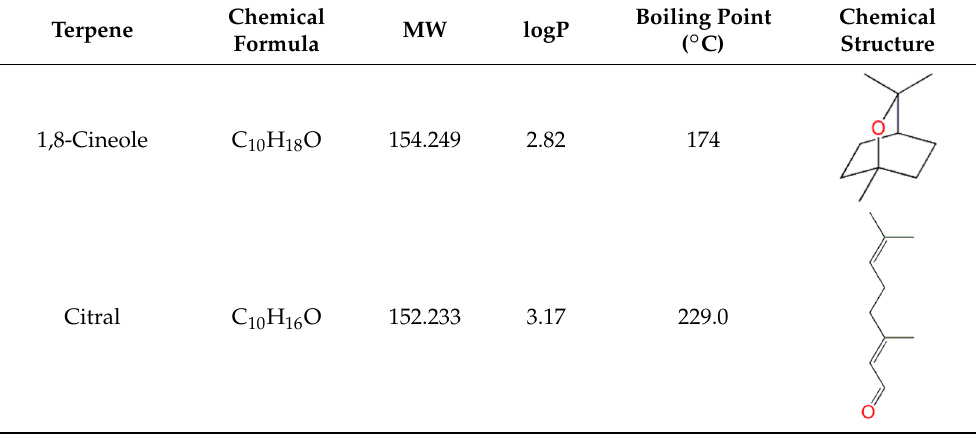
Table 1. Physicochemical parameters of the tested oxygen-containing terpenes.